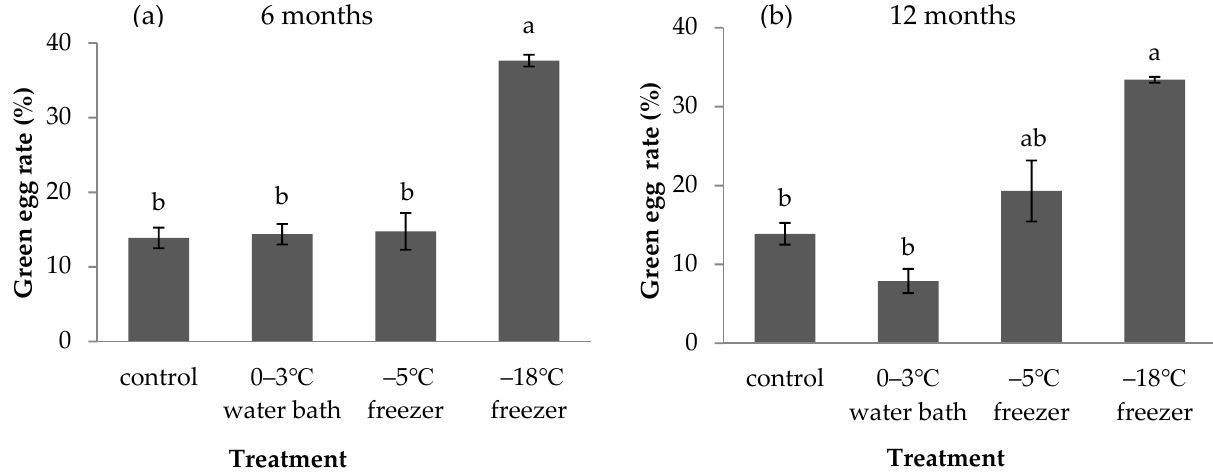
Figure 2. Rate of green eggs of A. pernyi eggs that were stored at low temperature for 6 months ( a ) and 12 months ( b ) (mean ± SE%). Control represents fresh eggs. Bars sharing the same letters are not significantly different ( a : one-way ANOVA, followed by LSD multiple comparison tests, p < 0.05; b : one-way ANOVA, followed by Games–Howell multiple comparison tests, p < 0.05) between different treatments.